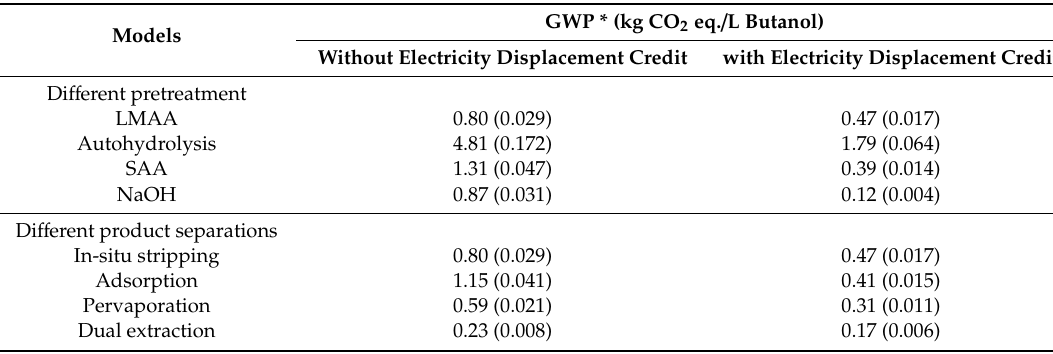
Table 12. Global warming potentials (GWP) of cellulosic butanol production plants employing 100% biomass-fueled CHP